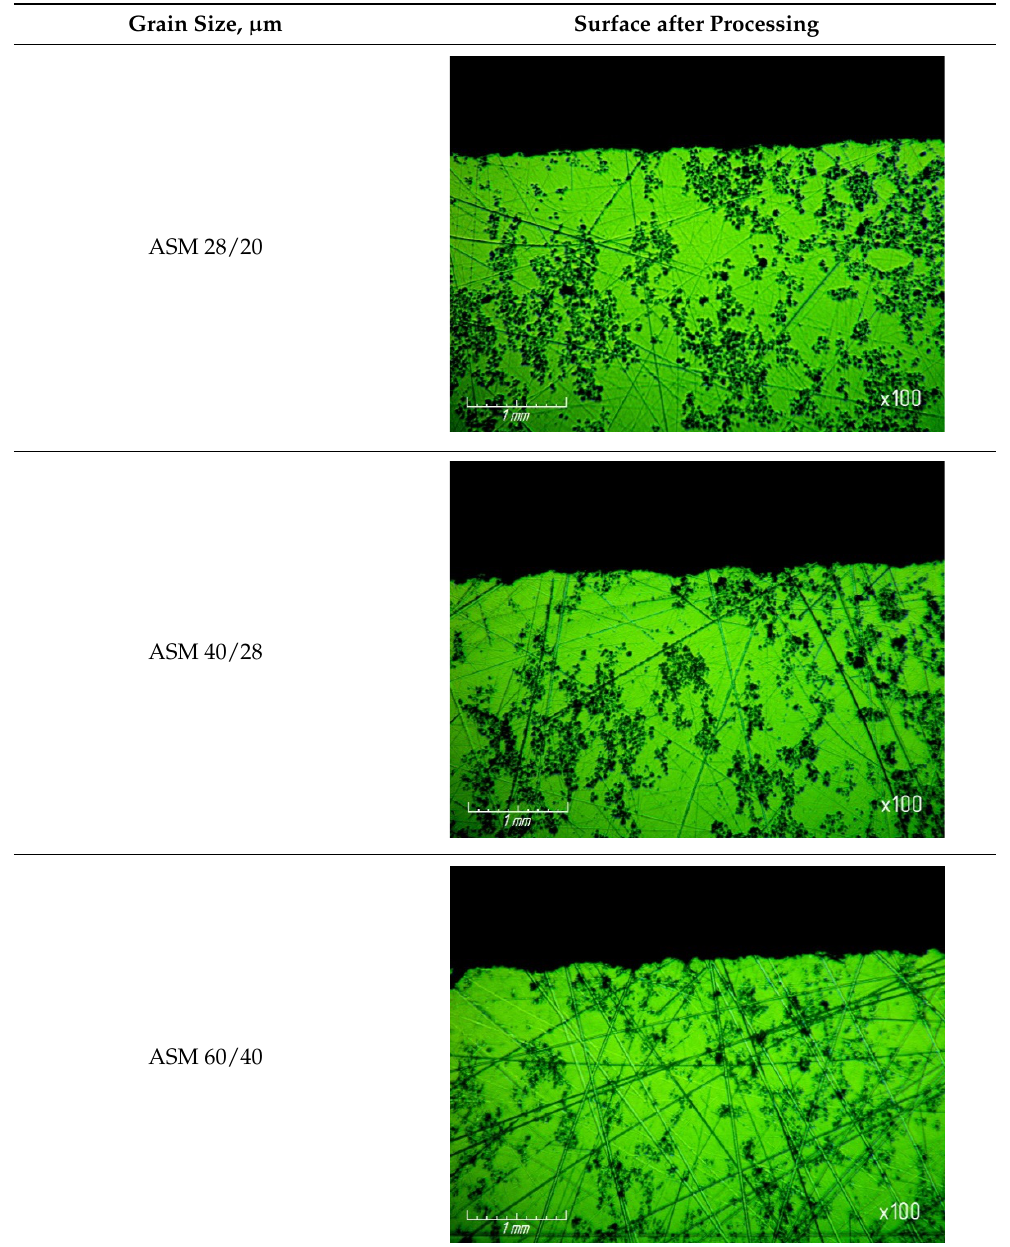
Table 9. Photos of the surface after processing on different grain sizes.